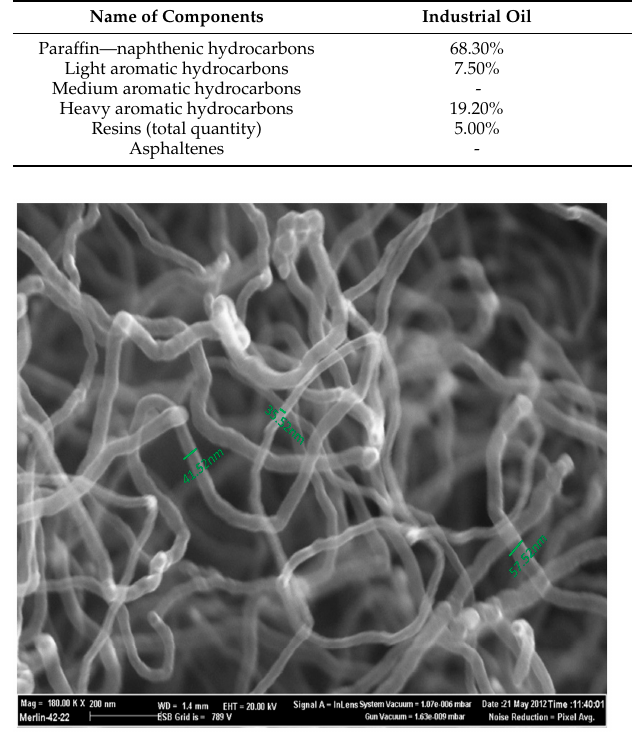
Figure 3. The structure of MWCNTS.